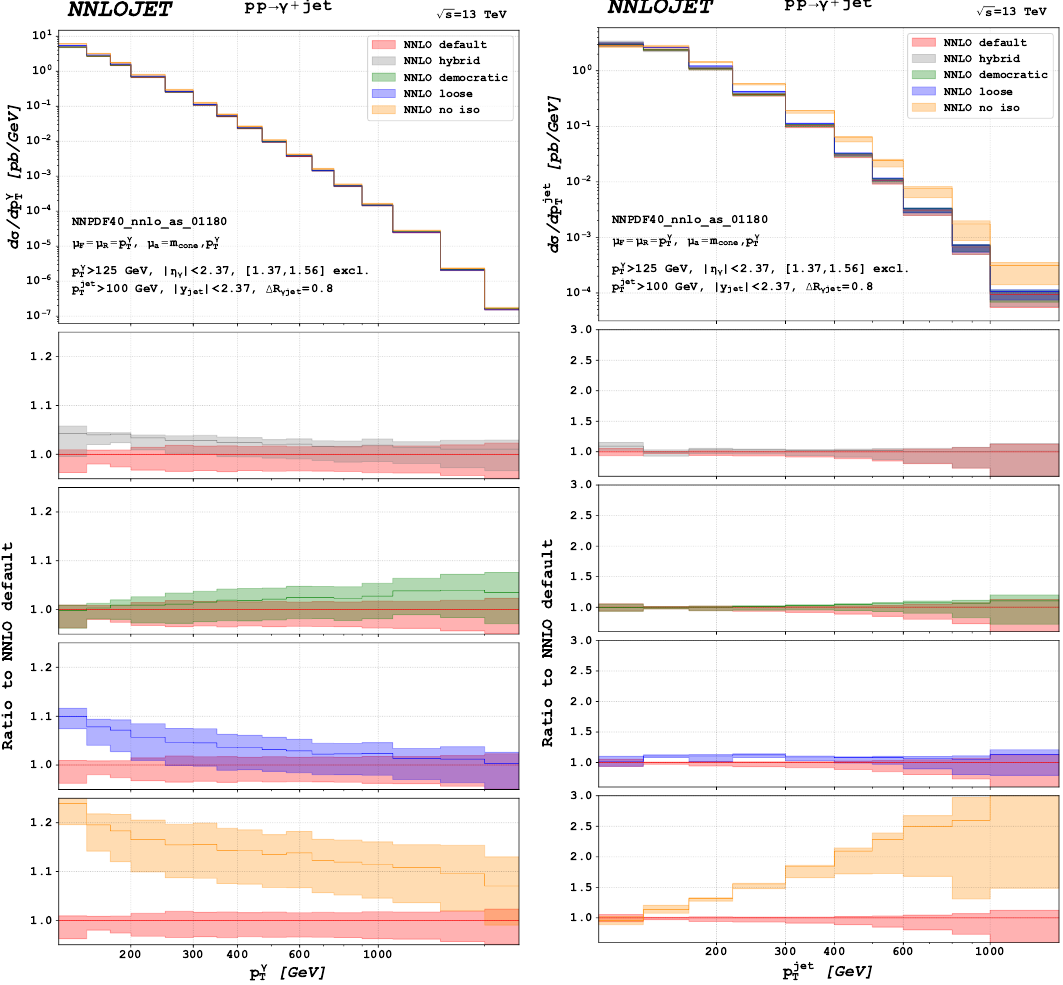
Figure 9. Predictions for the photon transverse momentum (left) and jet transverse momentum distributions (right) with different isolation